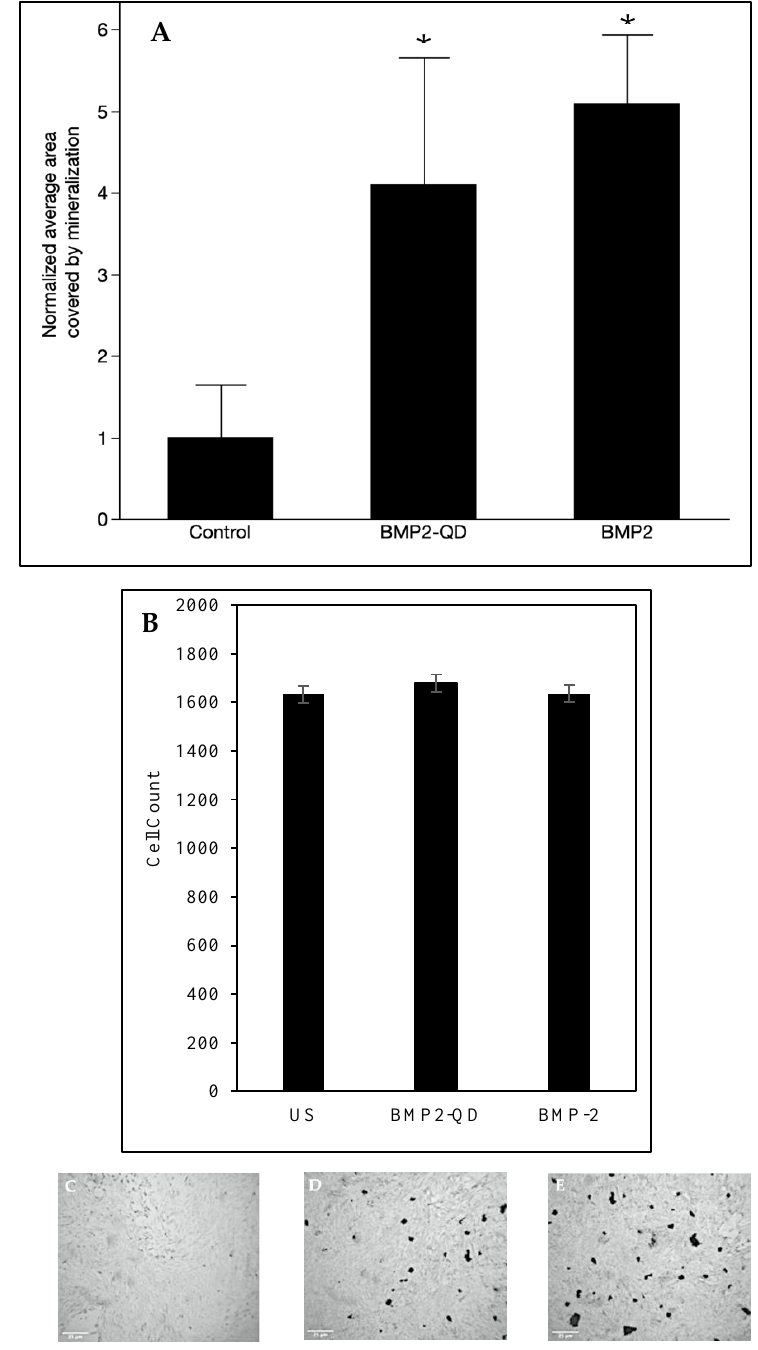
Figure 5. ( A ) Mineralization deposits of C2C12 cells left unstimulated, treated with 40 nM BMP-2, or treated with 40 nM BMP-2-QDot ® s was determined using a von Kossa assay after five days. Cells were plated at a density of 1 × 10 4 cells per well. In total, 15 Images were randomly obtained for each condition using the Zeiss Axiovert 10 microscope at 5×/12 Achrostigmat objective. ( B ) Cell count to demonstrate viability of cells. At least five images were counted using ImageJ following the von Kossa assay. ( C – E) Representative images of the cells from each treatment are located underneath the bar graph. This experiment was repeated independently at least three times. Data were analyzed using ImageJ and one-way ANOVA followed by the Student’s t -test. * indicates statistical significance at p < 0.05 when compared to unstimulated cells.